Question: Express in one sentence what the figure is showing.
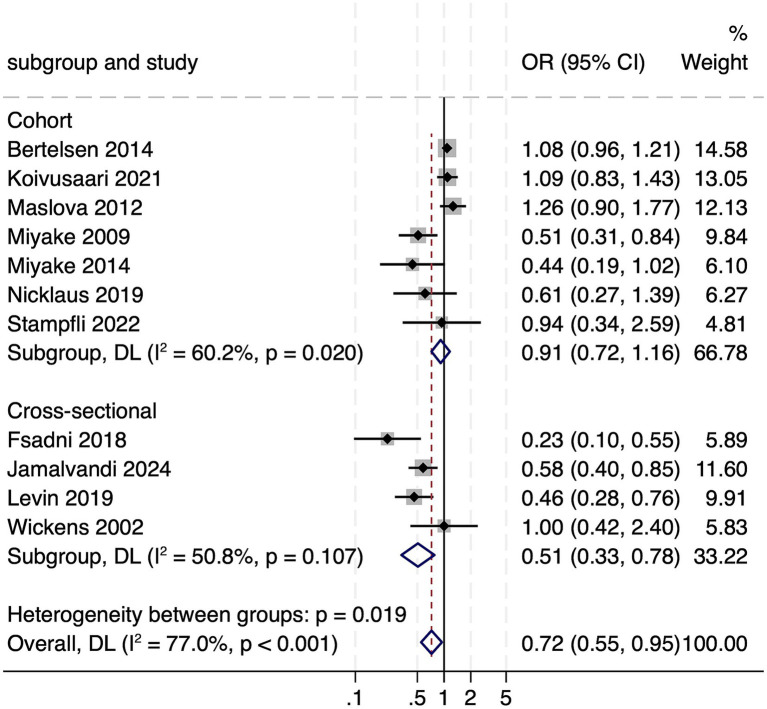
Answer: Forest plot of the overall association between fermented dairy consumption and the risk of childhood asthma/wheeze, with subgroup analysis by study design.